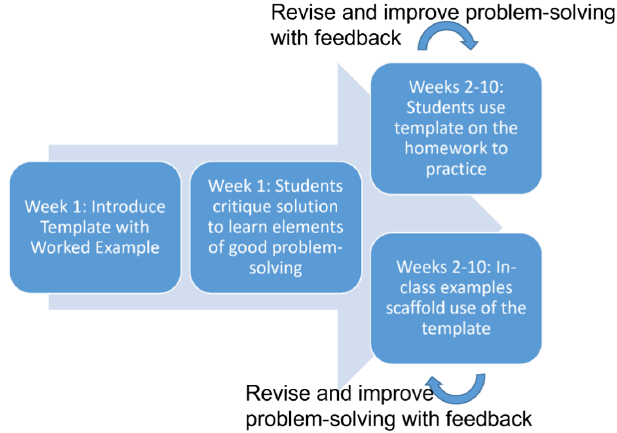
FIG. 1. Graphic illustrating how the template was introduced and used in the course.